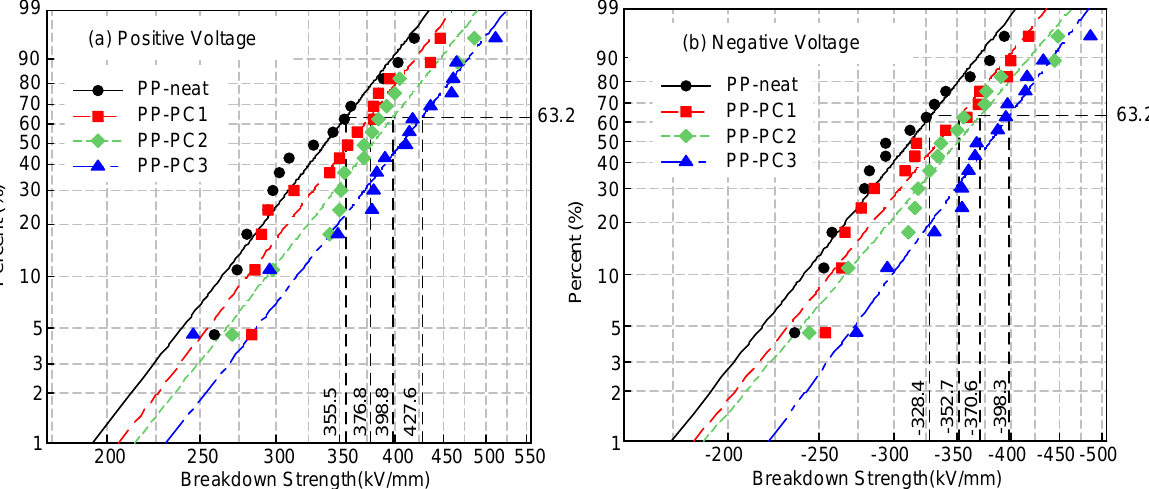
◦ C: ( a ) positive voltage; ( b ) negative